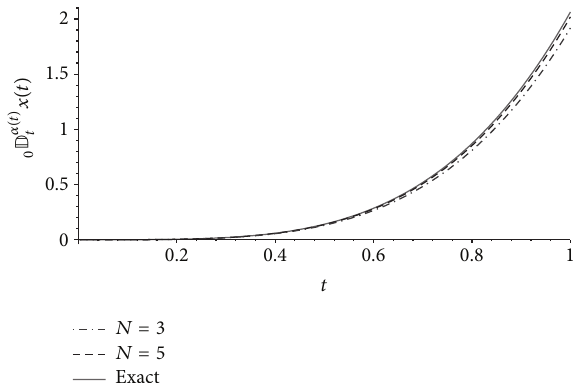
Figure 3: Exact (47) and numerical approximations of the left Marchaud derivative 0 D 𝛼(𝑡) 𝑡 𝑥(𝑡) with 𝑥(𝑡) = 𝑡 4 and 𝛼(𝑡) = (𝑡 + 1)/4 obtained from Theorem 7 with 𝑛 = 2 and 𝑁 ∈ {3,5} . The error (48) is 𝐸 ≈ 0.04919 for 𝑁 = 3 and 𝐸 ≈ 0.01477 for 𝑁 = 5